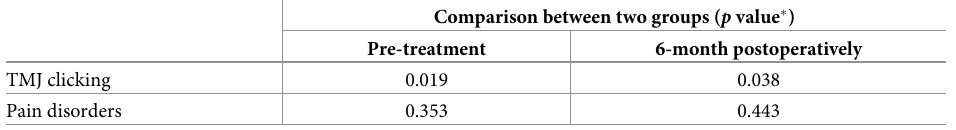
Table 4. Comparison of pre-treatment and postoperative prevalence of TMJ symptoms between orthodontics- first approach and surgery-first approach groups. Comparison between two groups ( p value � )